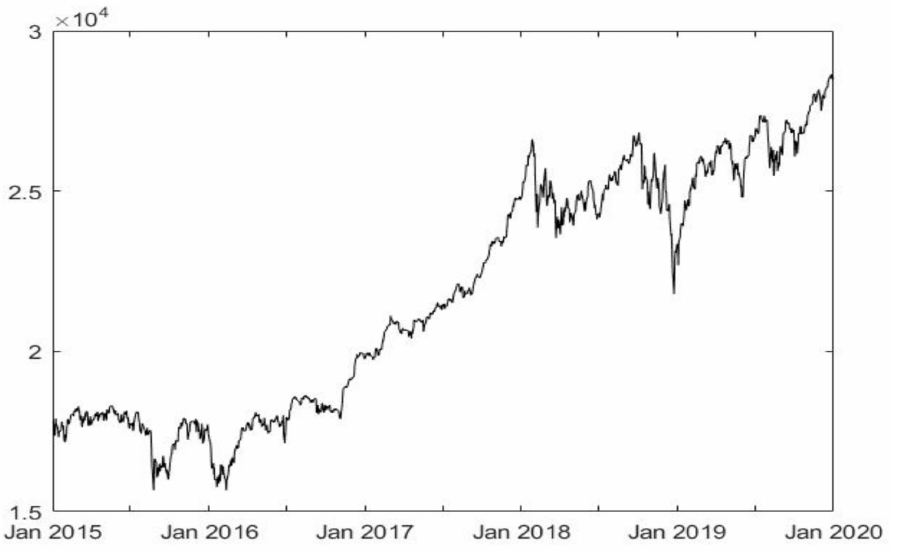
Figure 2. Historical development of the DJIA stock